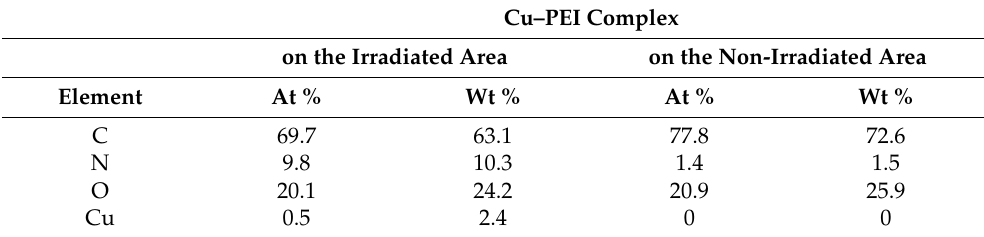
Table 5. EDS analysis a results of Cu–PEI